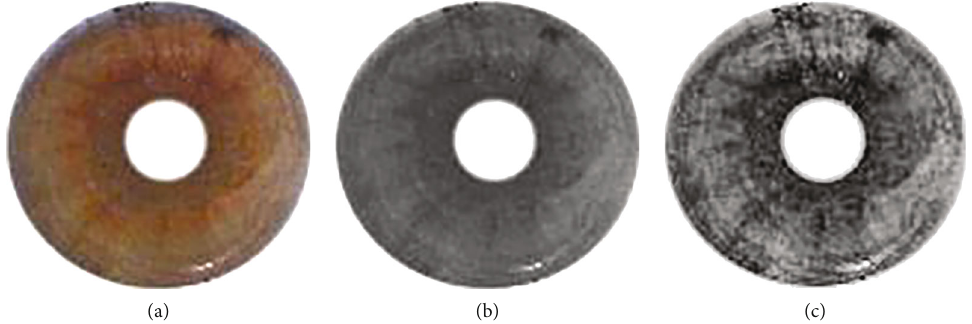
Figure 1: Iris images: (a) original RGB iris images, (b) grayscale conversion iris images, and (c) iris image enhancement with